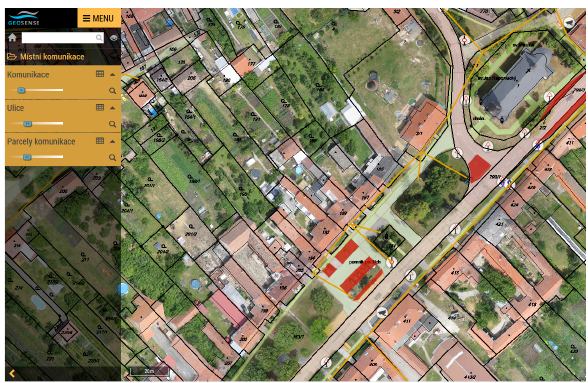
Figure 6: Geoportal application with technical map, communications and other data derived from detailed orthophoto